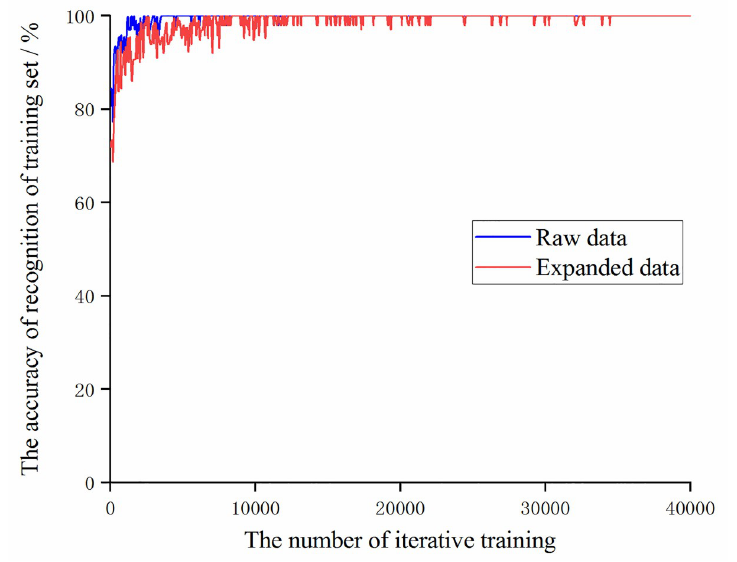
Fig 5. The trend of the accuracy of the training set of the original data and the augmented data with the number of iterative training.